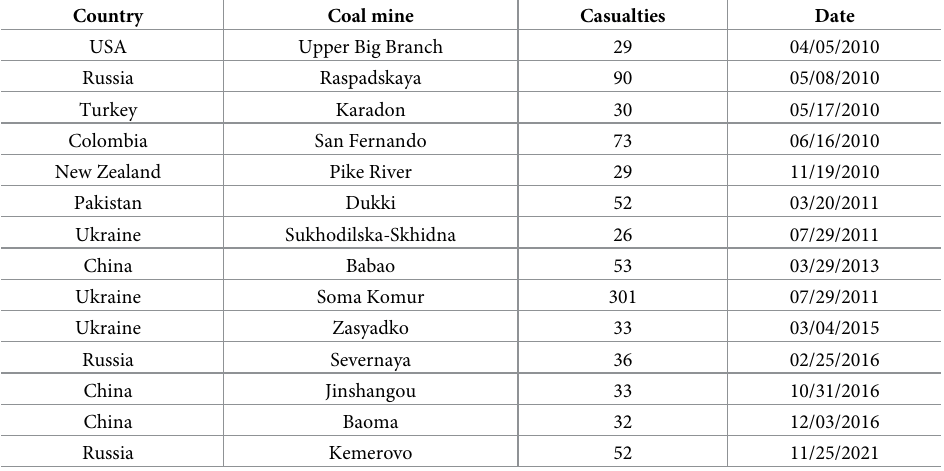
Table 1. Severe gas explosion in coal mines